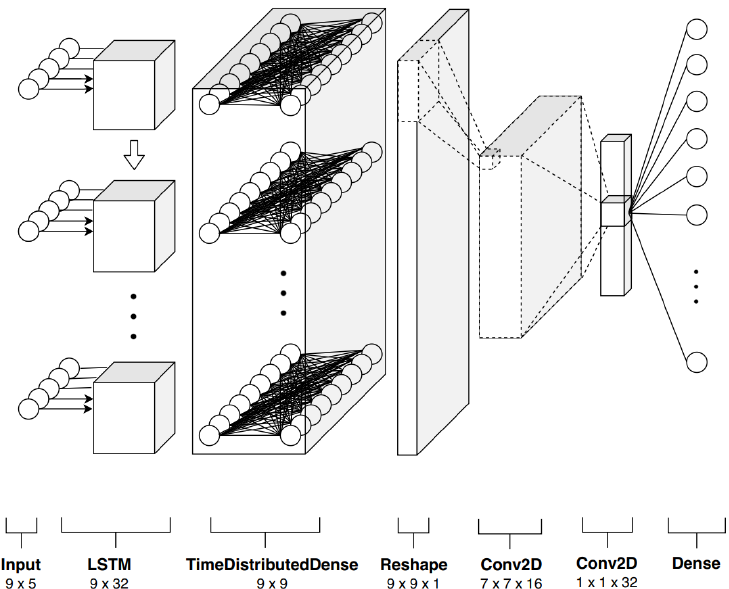
Figure 3. An overview of the pixel recurrent-convolutional neural networks (R-CNN) model used for classification. Given a multi-temporal, multi-spectral input pixel X ( i ) , the first layer of long short-term memory (LSTM) units extracts sequences of temporal patterns. A stack of convolutional layers hierarchically processes the temporal